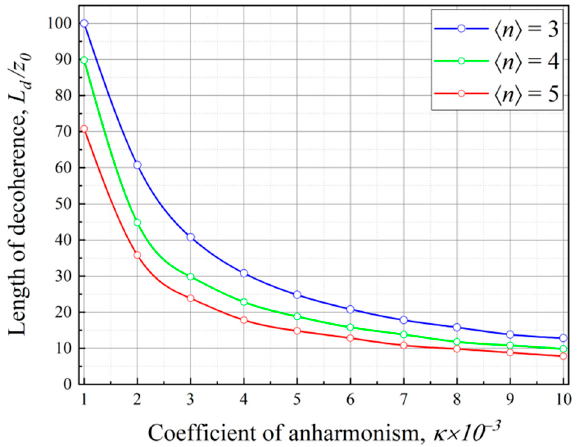
Figure 7. The coherence length of the spatial transverse oscillations of the beam in the non-ideal waveguide obtained through the integral of overlapping (see the text) for different initial states.